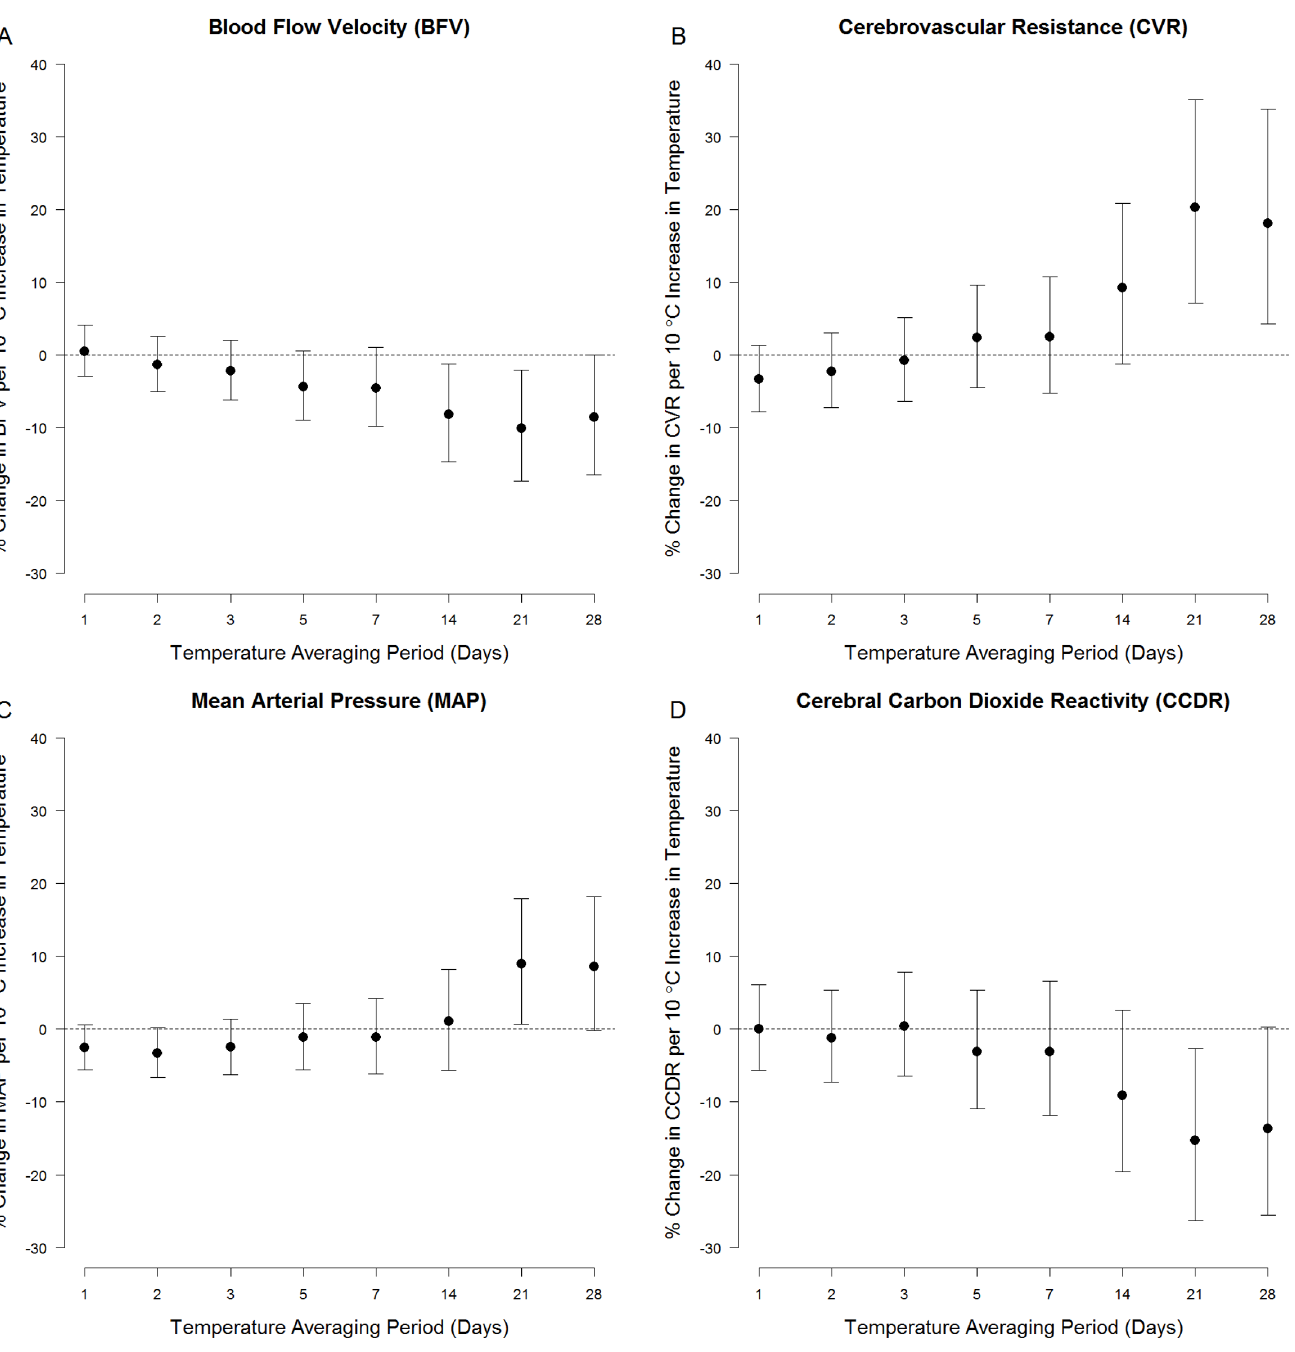
Fig 1. Association between ambient temperature and (A.) resting blood flow velocity (BFV), (B.) resting cerebrovascular resistance (CVR), (C.) resting mean arterial pressure (MAP), (D.) and cerebral varoreactivity (Cerebral VR). The y -axis denotes the % change (and 95% confidence interval) in each outcome per 10°C increase in temperature, adjusted for age, sex, race, smoking, hypertension, diabetes, BMI, visit number, day of week, season, and long-term time trends. The x-axis denotes the averaging period for ambient temperature (in days) prior to the TCD assessment.